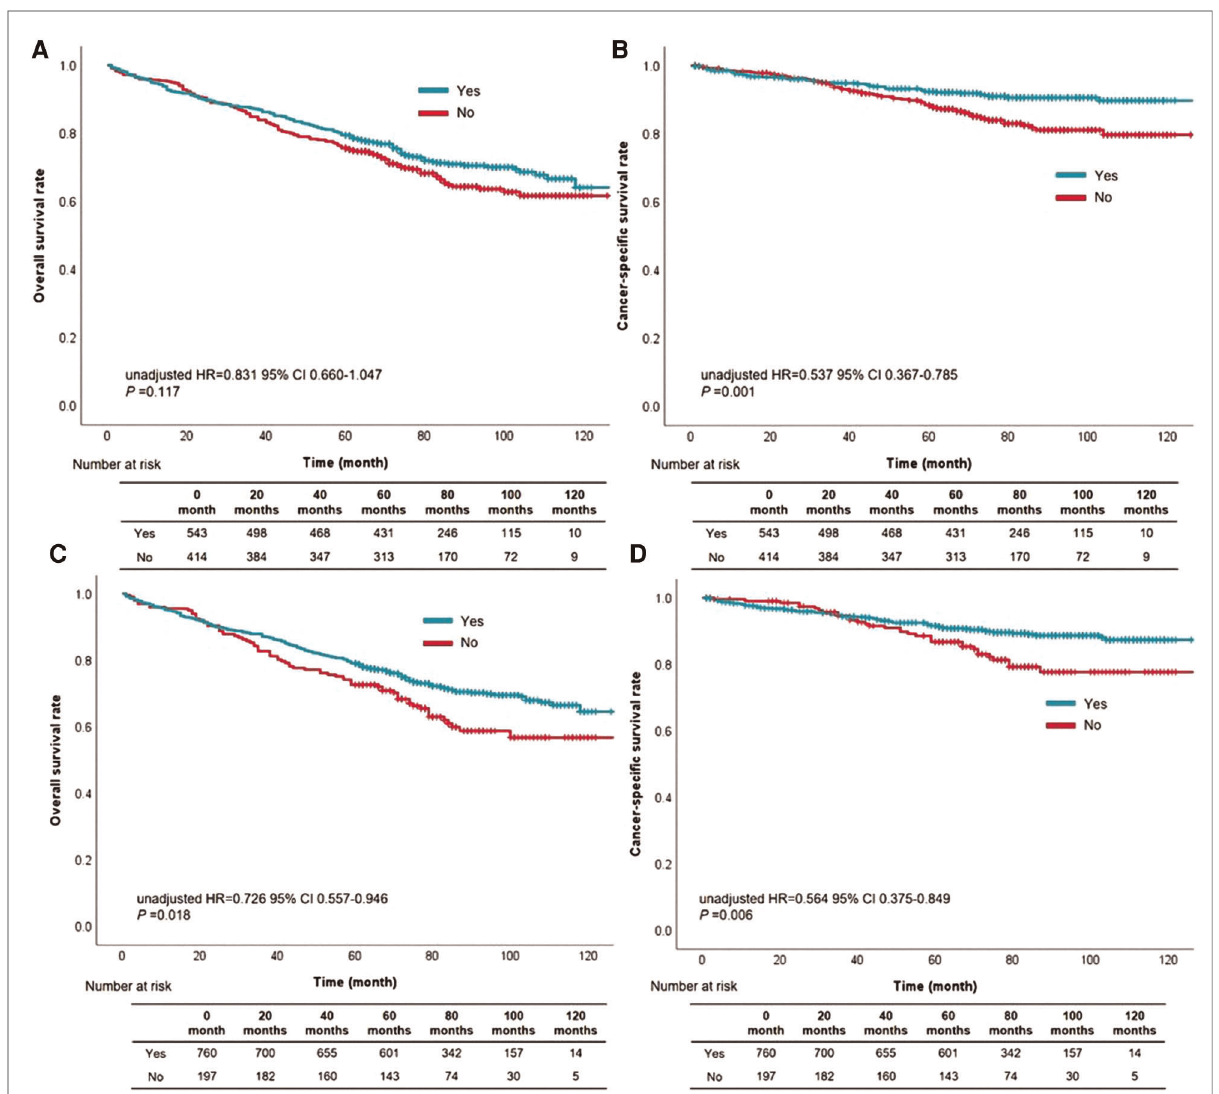
FIGURE 3 The survival curves based on waiting time within one month for overall survival ( A ) and cancer-speci fi c survival ( B ), or waiting time within two months for overall survival ( C ) and cancer-speci fi c survival ( D